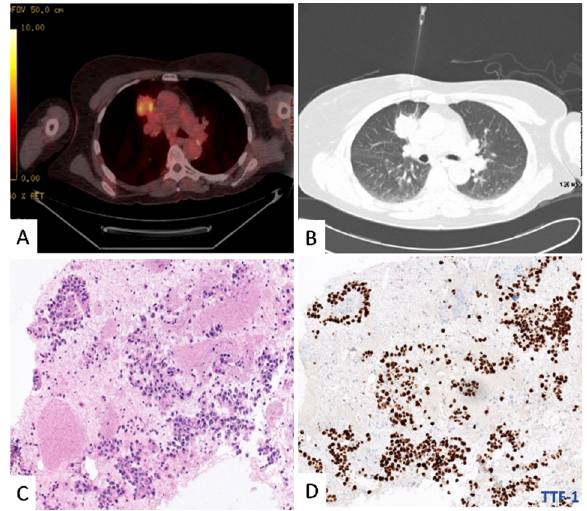
Figure 1. ( A ) PET-CT image of a right upper lobe mass (4.6 cm × 2.9 cm) with SUVmax of 9.2. ( B ) Initial diagnostic biopsy–20 GCT guided transthoracic needle aspiration of the lung mass. ( C